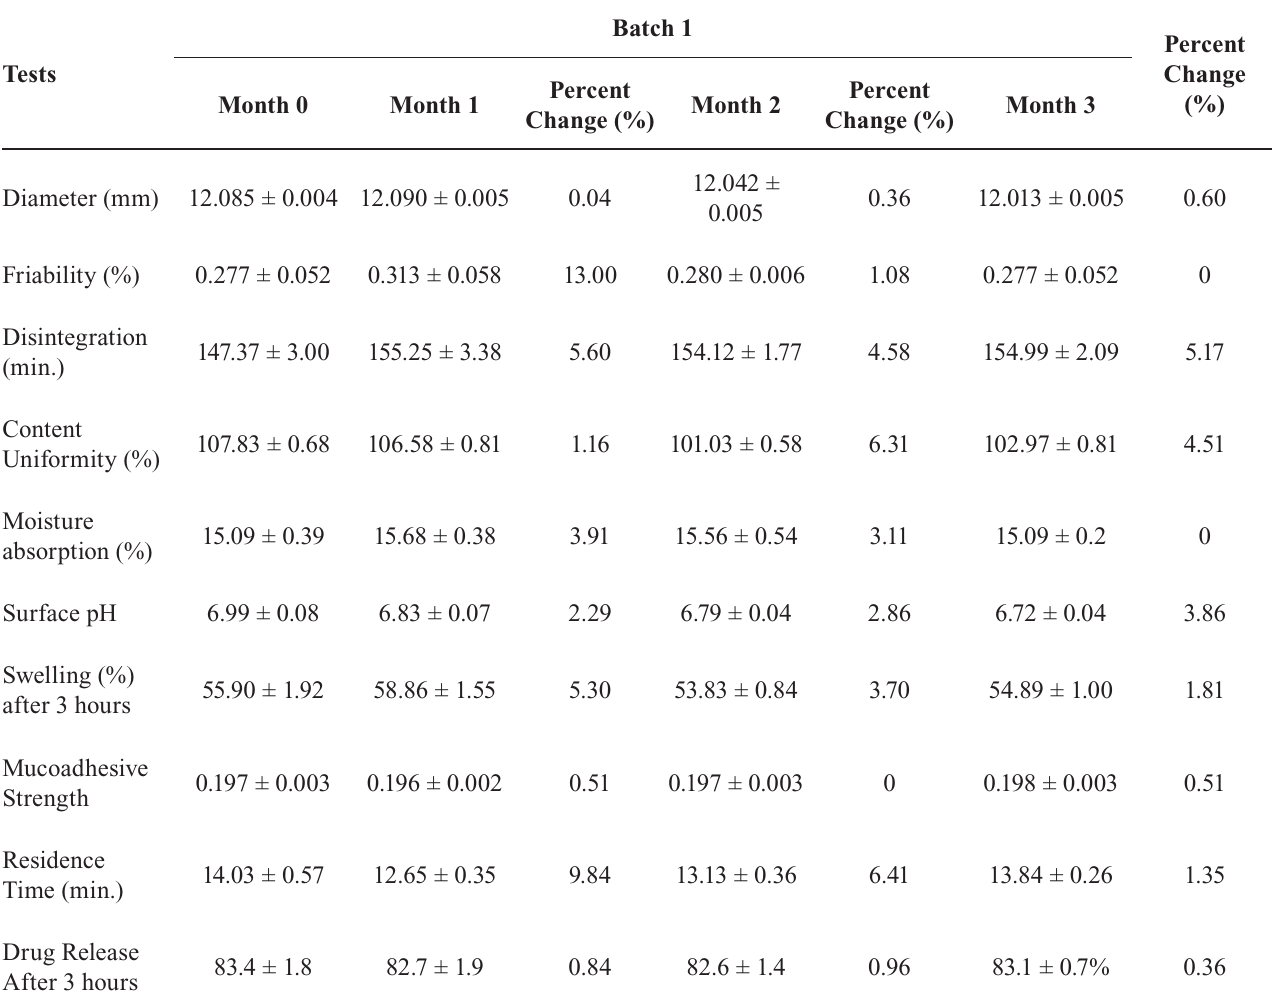
TABLE V - S ummary of the results for batch 1: formulated mucoadhesive mefenamic acid buccal tablet